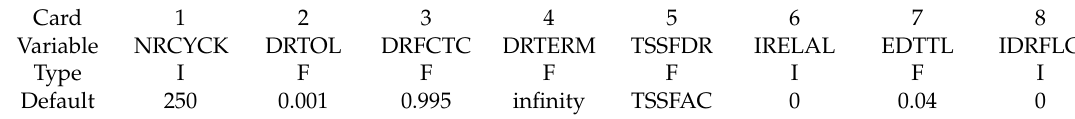
Table 5. Parametric control card for dynamic relaxation in LS-Dyna [57].